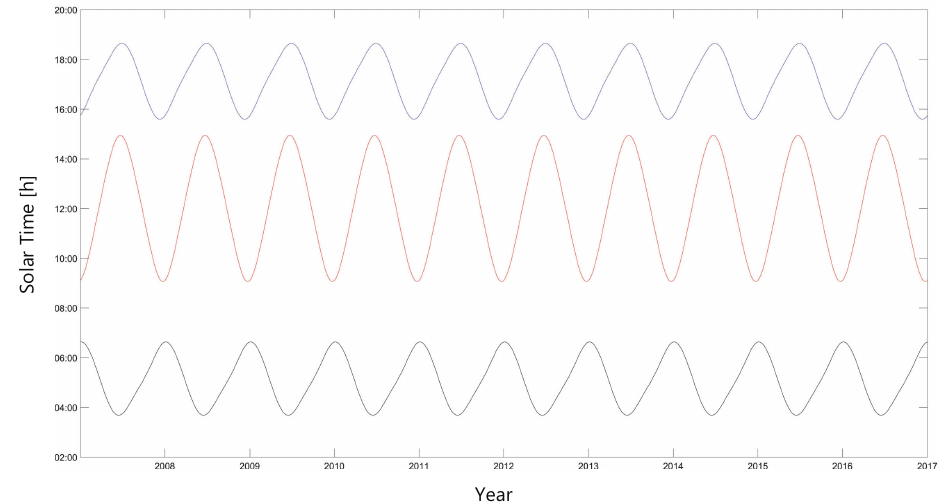
Figure 11. Solar time of sunrise (black), sunset (blue) and length of day